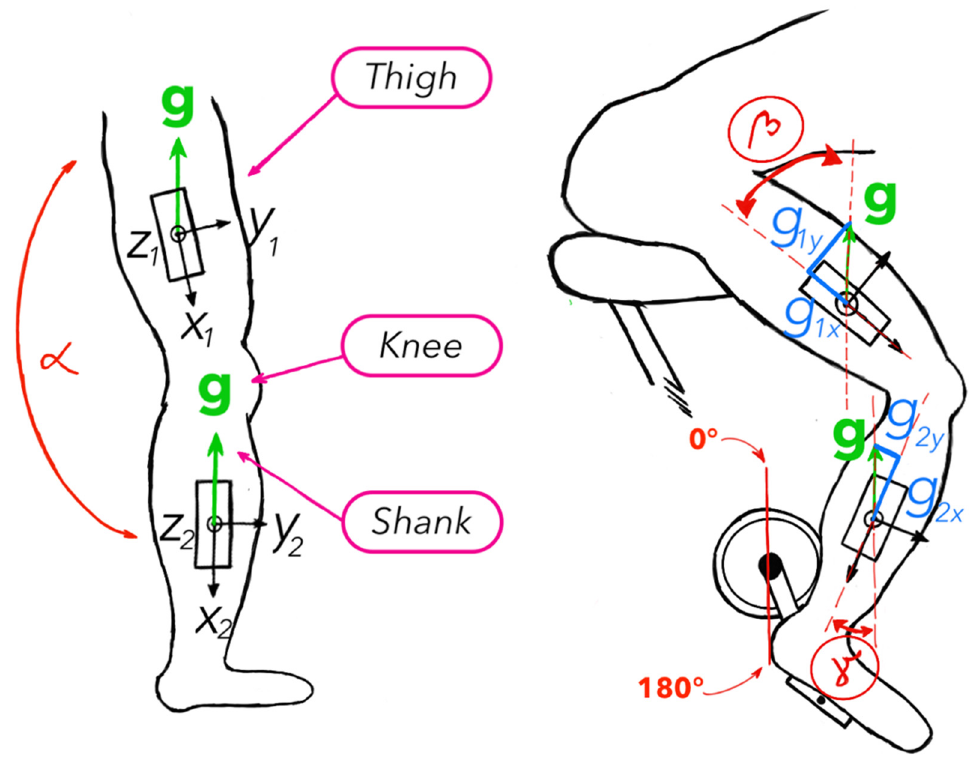
Figure 1. Placement of the IMUs on each body segment during standing position and during cy- cling.